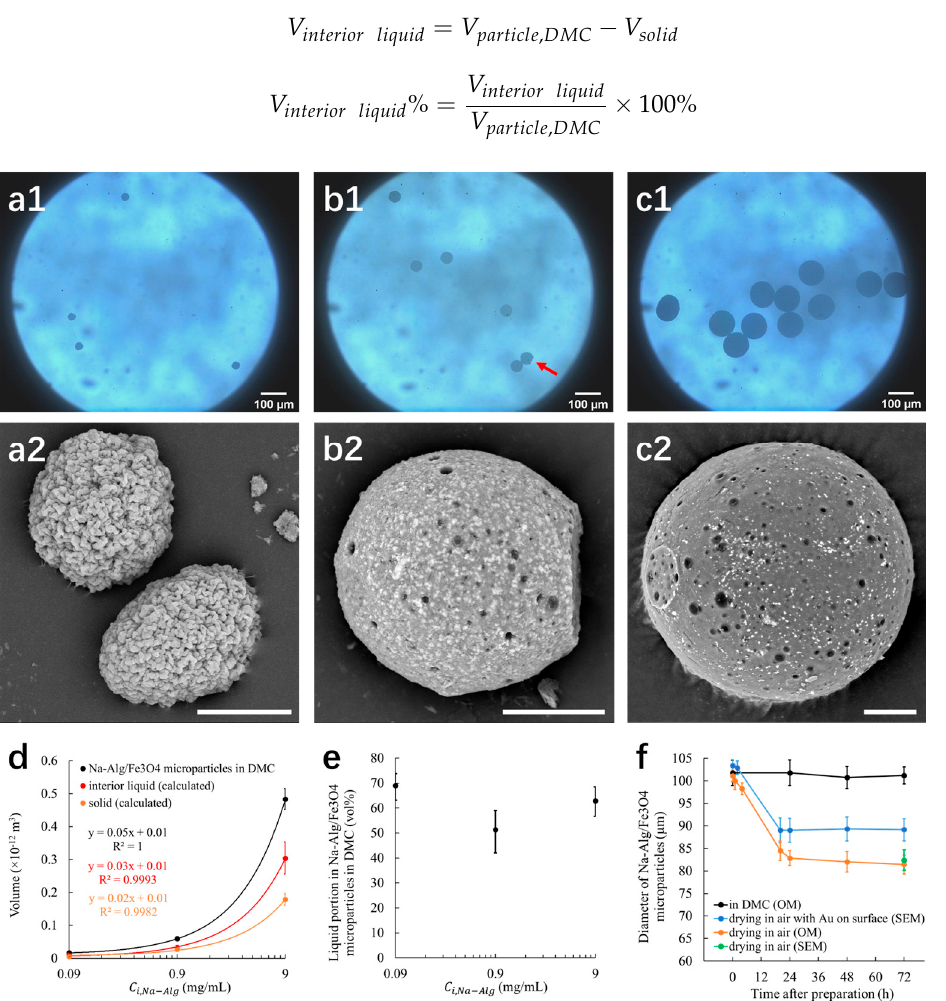
Figure 2. ( a1 , b1 , c1 ) Optical microscopic images and ( a2 , b2 , c2 ) SEM images of Na-Alg/Fe 3 O 4 microparticles. The initial concentration of Na-Alginate in dispersed fluid ( C i , Na - Alg ) for the preparation is ( a1 , a2 ) 0.09 mg/mL, ( b1 , b2 ) 0.9 mg/mL, ( c1 , c2 ) 9 mg/mL. The red arrow in b1 shows the neat cross section. SEM scale bar 20 µm. Relationship between C i , Na - Alg and ( d ) Na-Alg/Fe 3 O 4 microparticle volume, interior liquid volume, solid volume; ( e ) liquid portion in Na-Alg/Fe 3 O 4 microparticles in DMC. ( f ) Evolution of the diameter of Na-Alg/Fe 3 O 4 microparticles (prepared with C i , Na - Alg at 9 mg/mL) in different